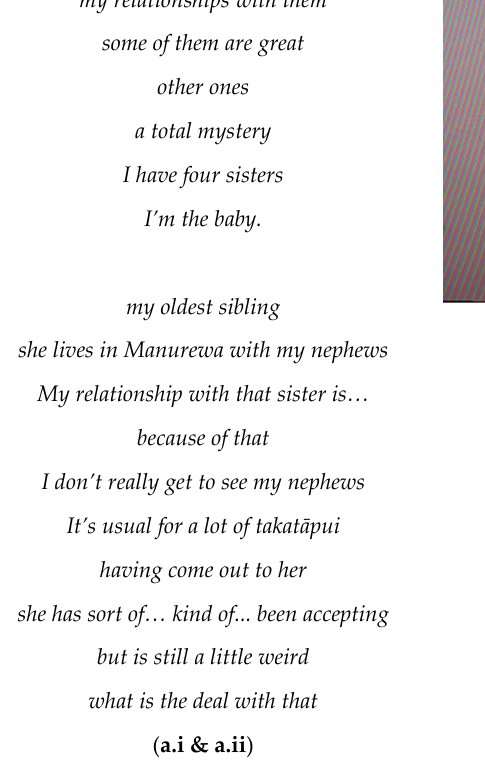
Figure 2. This figure depicts ( a.i ) Stanza 3 of the poem; ( a.ii ) Stanza 4 of the poem; ( b ) Image of jewellery given to Waimirirangi by her sister on her